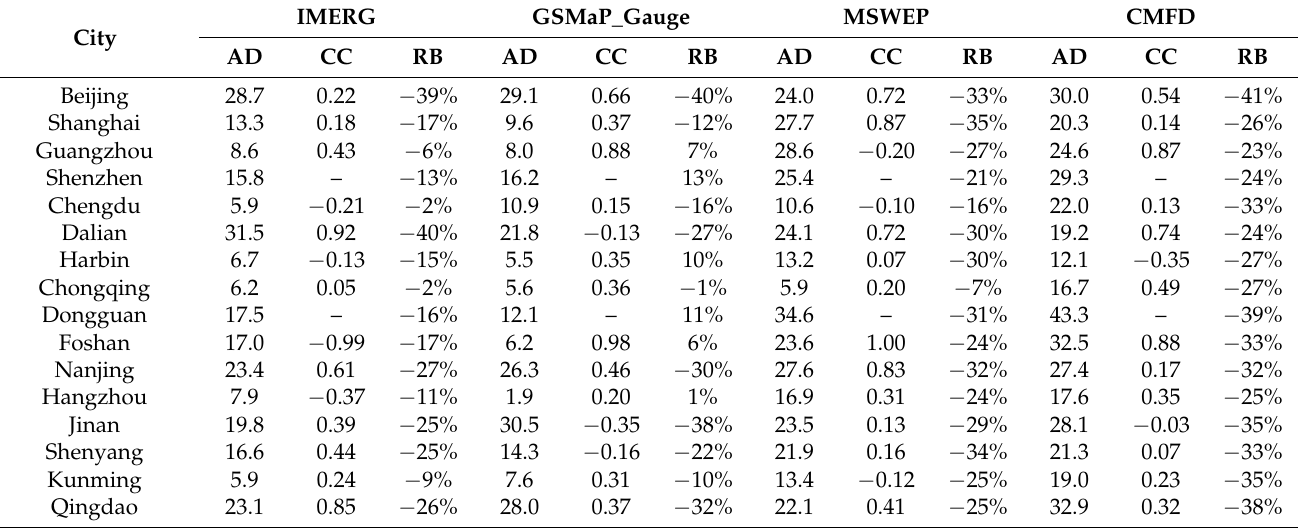
Table 4. The difference of R99 between the SPPs data and gauge observations in 21 major